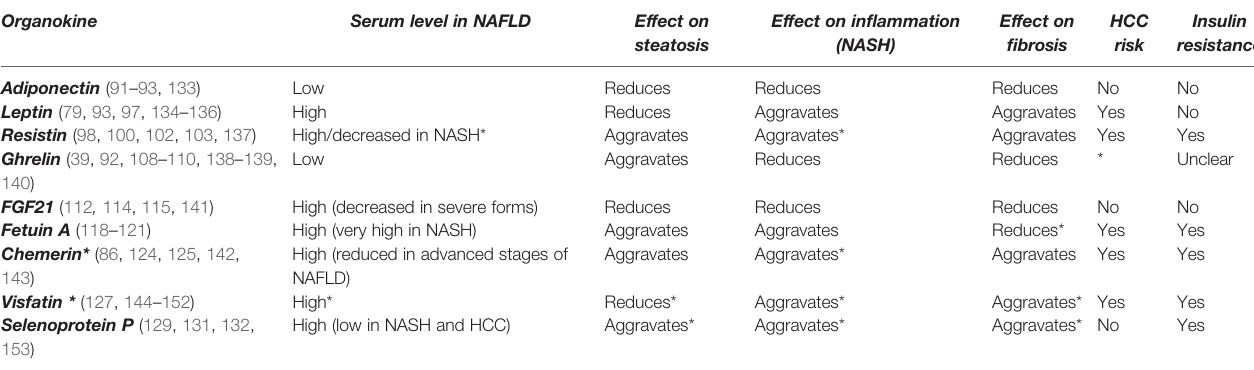
TABLE 4 | Potential effects of the main hepatokines and adipokines on non-alcoholic fatty liver disease pathogenesis (29, 30, 92, 102).